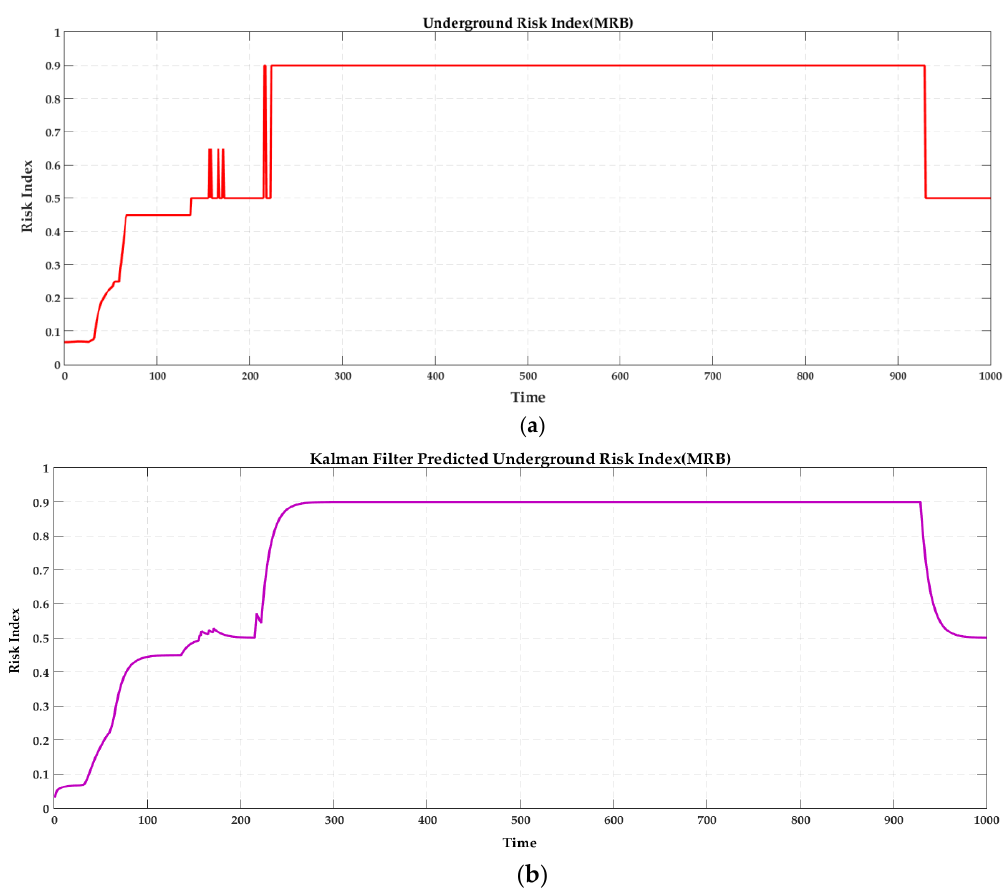
Figure 19. ( a ) Output values of the SHFL model using M RB rules definition method; ( b ) predicted values using Kalman filter for underground risk index.